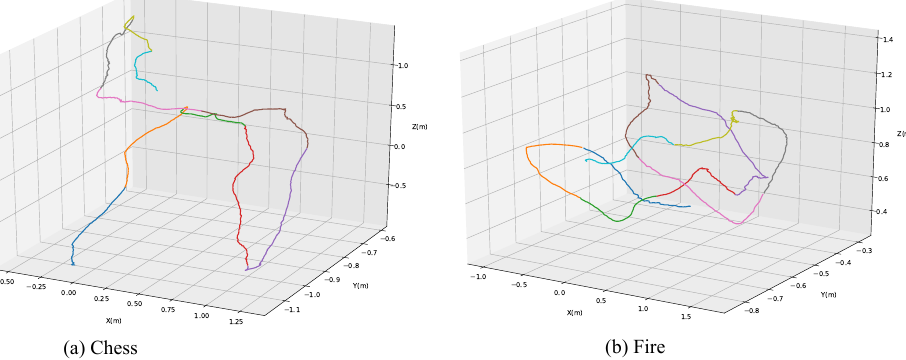
Figure 7. Camera trajectory in Chess scene(seq-01) and Fire scene(seq-01). We use k-means for unsupervised clustering of camera trajectory. The different colored curves in the figure represent clustering